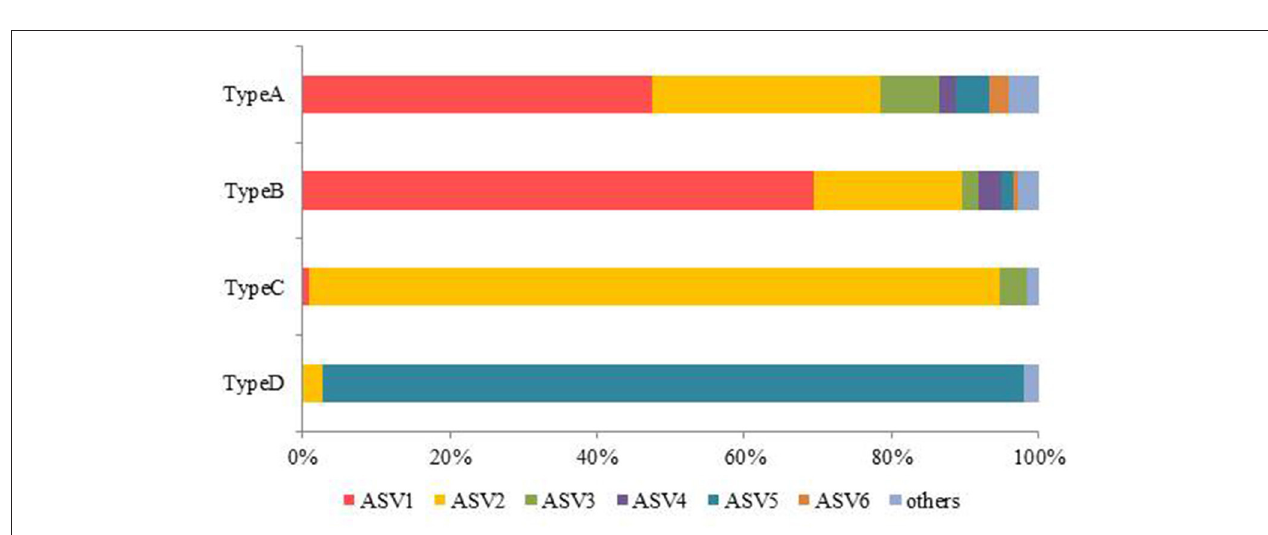
FIGURE 9 | Mean relative abundance of algal ASVs containing the four pigment